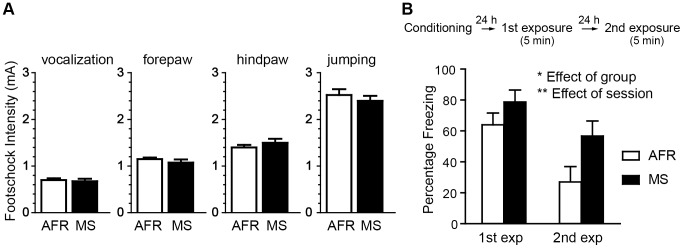
Effect of MS on freezing behavior in conditioned fear stress (CFS).
A, Sensitivity to pain induced by electrical stimulation. The minimal levels of the current required to elicit the stereotypical response of vocalization, limb withdrawal of the forepaw, limb withdrawal of the hindpaw and jumping were determined. Data are represented as pain thresholds (mA) (n = 8 per each group). B, Freezing rates of the MS and the AFR rats in the first exposure of 24 h after and the second exposure of 48 h after the fear conditioning by a 2.0 mA footshock. Two-way repeated ANOVA revealed significant main effects of the group (*p<0.05) and session (**p<0.01) but no significant interactions between the group and session (n = 10–12 per group).